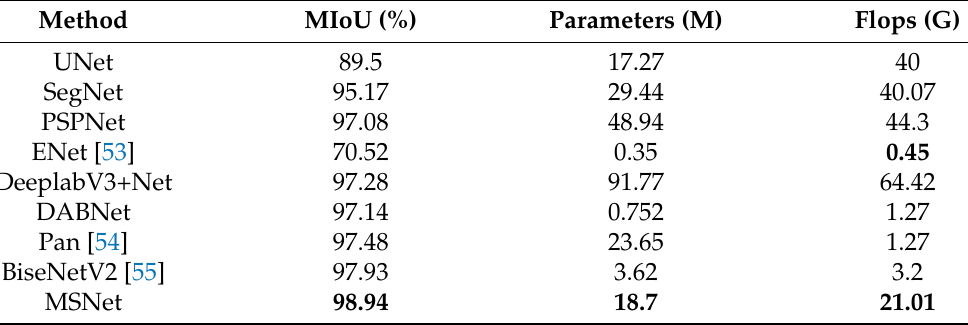
Figure 16. Diagram comparing the effects of the MIoU values of different models. ( a ) Real image; ( b ) label; ( c ) SegNet; ( d ) FCN32s; ( e ) DeepLabV3+; ( f ) PSPNet; ( g ) DABNet; ( h ) MSNet. Table 5. Generalization experiment on a public water-cover